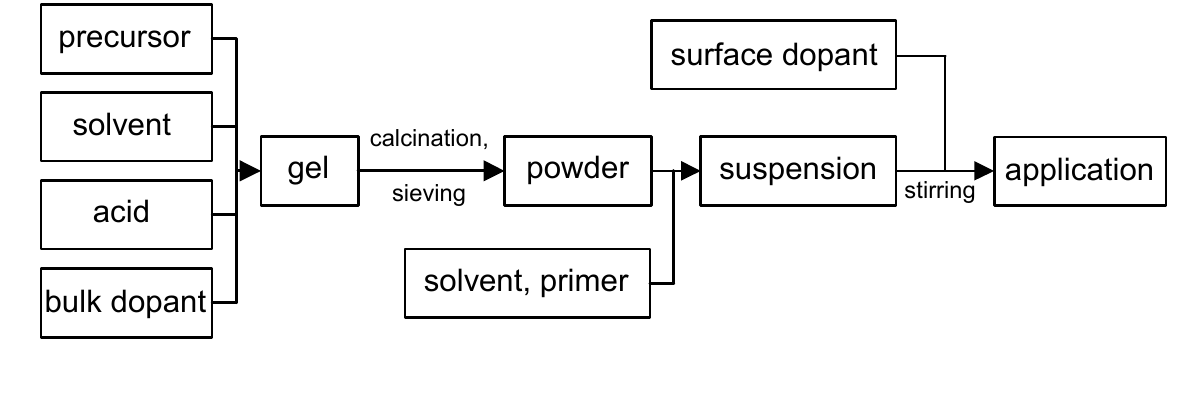
Figure 1. Workflow for the coating of